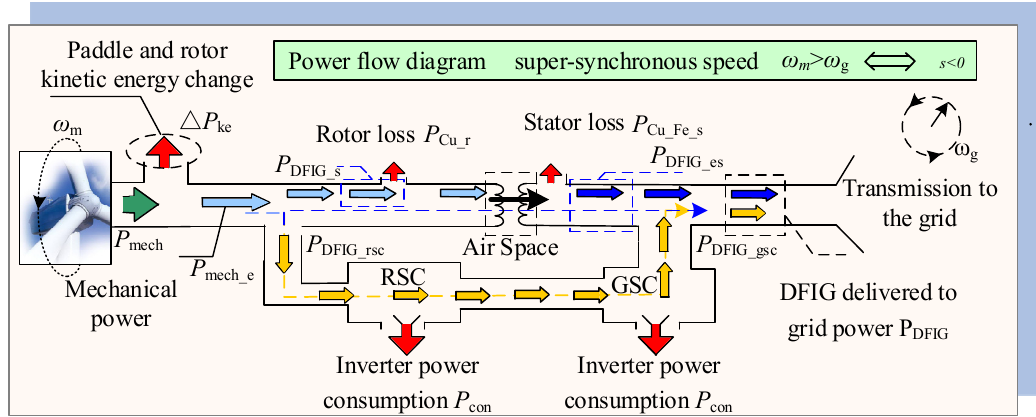
Figure 3. The power flow relation of the DFIG with an over-synchronous